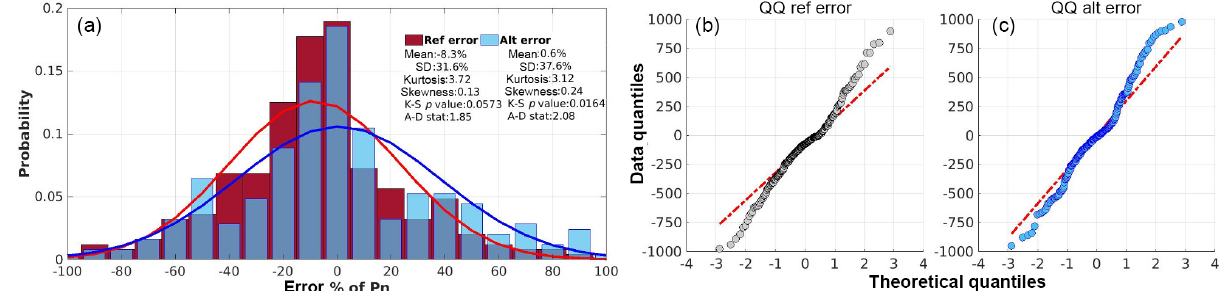
Figure 5. (a) Error distributions for the Prop and Ref method, experimental and theoritical quantile-quantile error plots for (b) Ref method and (c) Prop method, in park